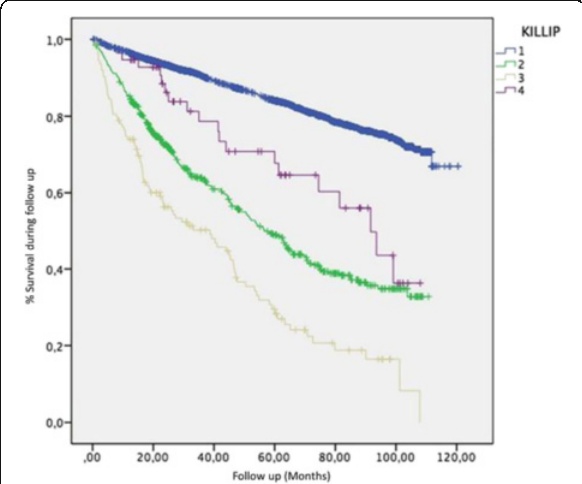
Fig. 85 (abstract A195). Mortality in follow up by Killip